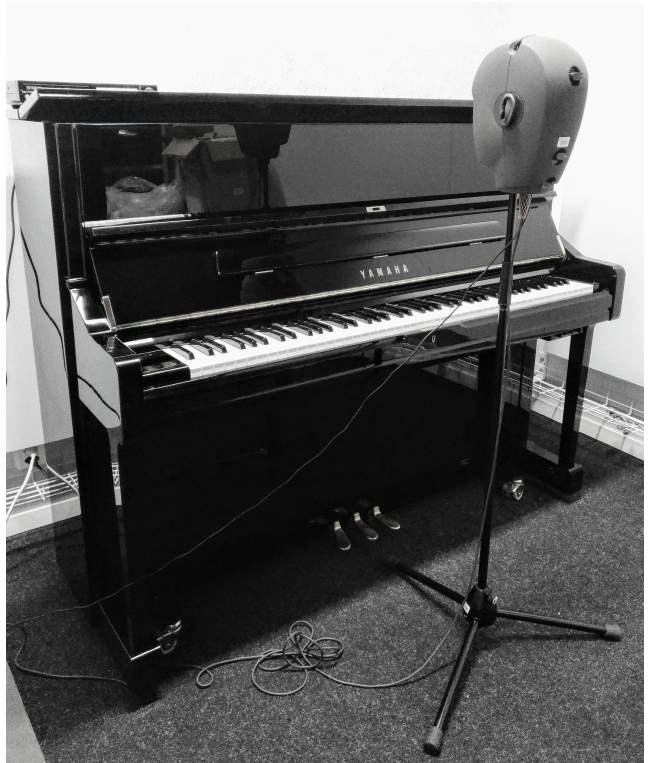
Figure 1. Binaural audio recording setup in Zurich (ZH). Piano lid in ‘semi-open’